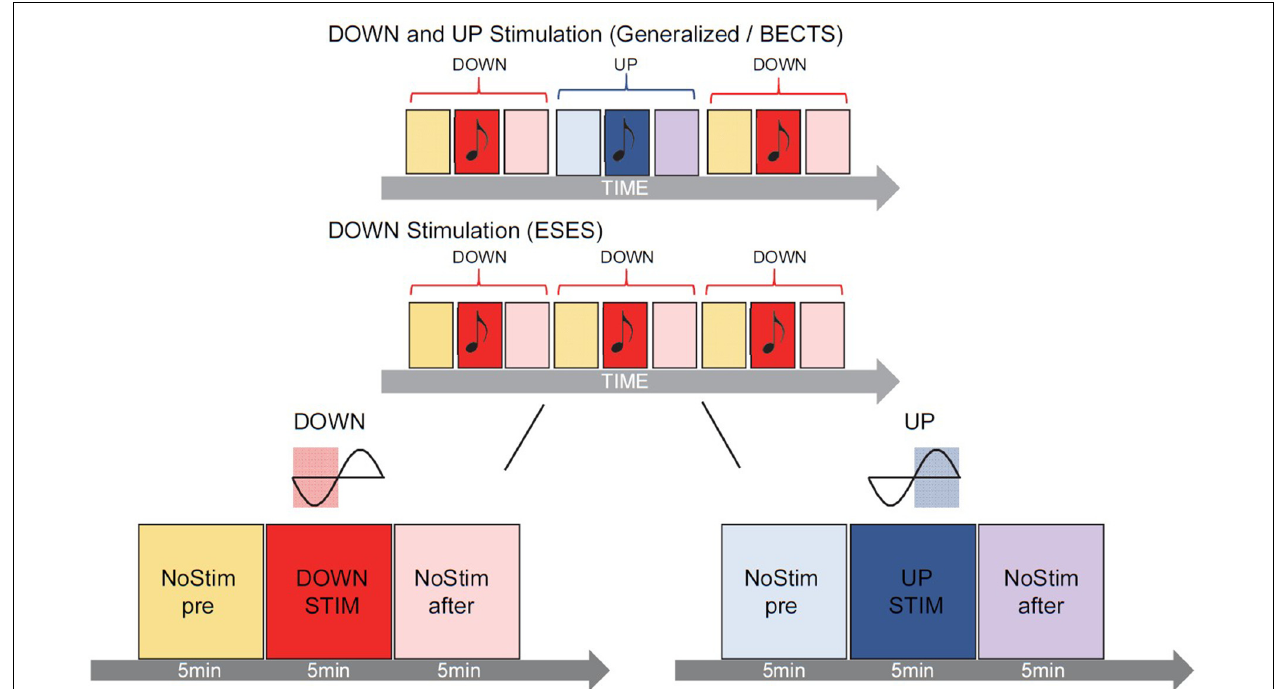
FIGURE 1 | Graphical illustration of the acoustic stimulation. During the night, slow waves were detected online in real time and tones were presented according to a 3 × 5-min-block design. One stimulation cycle consisted of 5 min no stimulation (NoStim pre ), 5 min stimulation (DOWN or UP) followed by 5 min no stimulation [(NoStim after ), shown for DOWN (left) and UP stimulation (right) enlarged on the bottom]. In patients diagnosed with benign epilepsy with centro-temporal spikes (BECTS) or generalized spike waves in sleep ( n = 3) tones onset during the stimulation blocks were played precisely time-locked either to the down-phase (DOWN, reddish color) or up-phase (UP, bluish color) of the detected slow wave, alternately in every other stimulation cycle (top panel). In patients diagnosed with ESES ( n = 2), only the DOWN stimulation (reddish color) was applied (middle panel). Stimulation was applied throughout the night when subjects were in deep sleep (i.e., N2 and N3, for further details see “Materials and Methods” section).